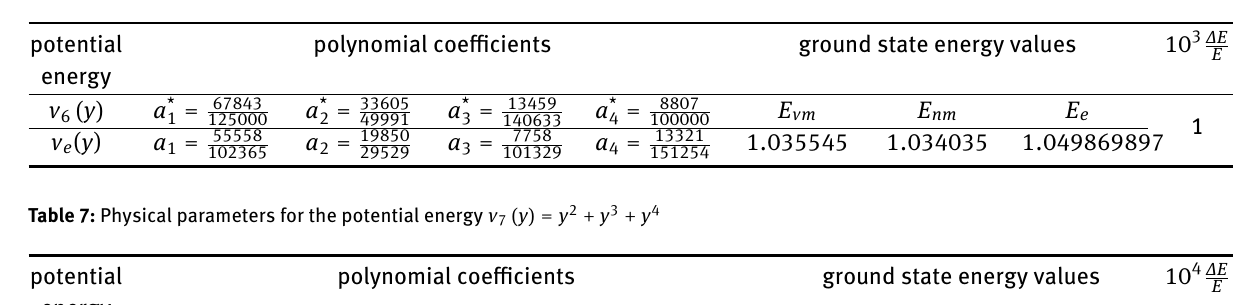
Table 6: Physical parameters for the potential energy v 6 ( y ) = y + y 2 + y 3 + y 4